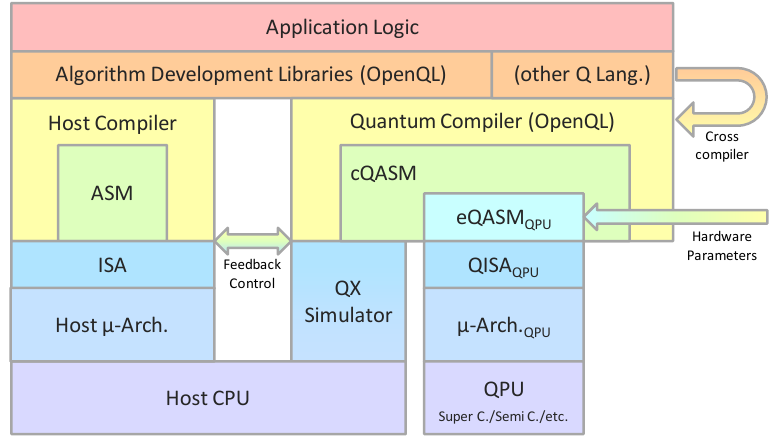
Figure 7. Quantum architectural stack.